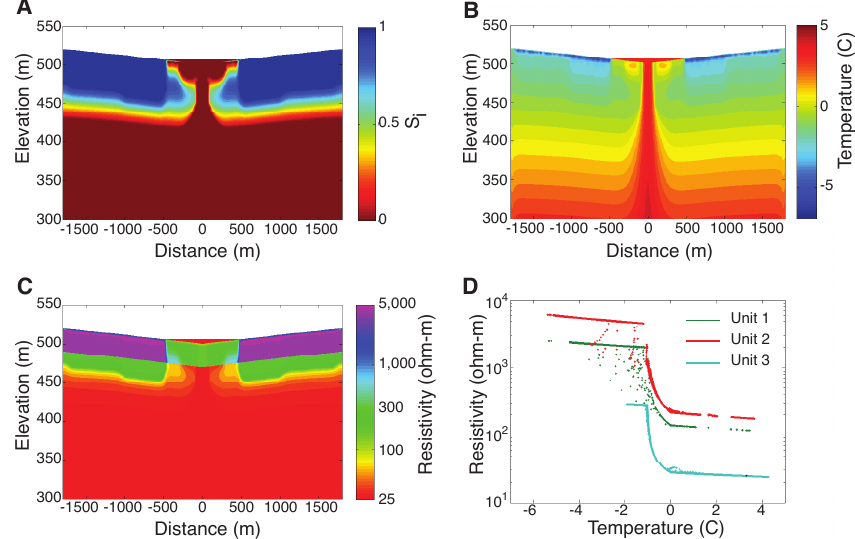
Figure 3. SUTRA model outputs and geophysical transformations from the 6m gaining lake simulation at 240 years. Ice saturation (a) and temperature (b) are converted to predictions of bulk resistivity (c) . Variability in resistivity as a function of temperature is indicated in (d) for lithologic units 1–3.